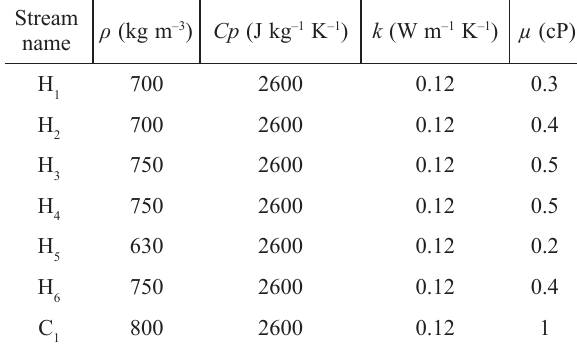
Table 7 – Physical properties data for case study